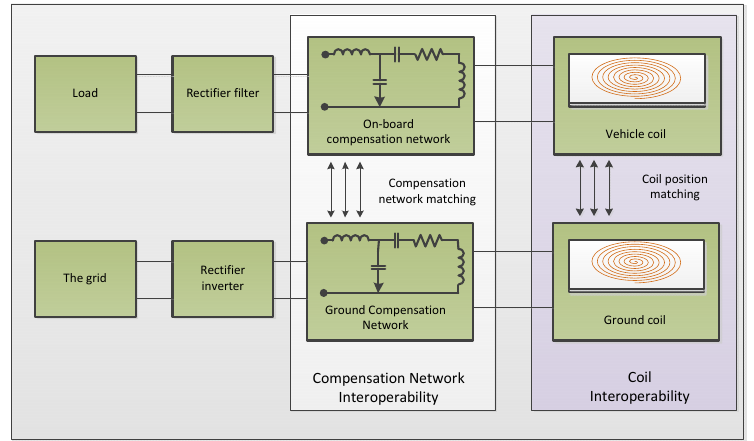
Figure 1. Schematic diagram of WPT interoperability system for electric vehicles.